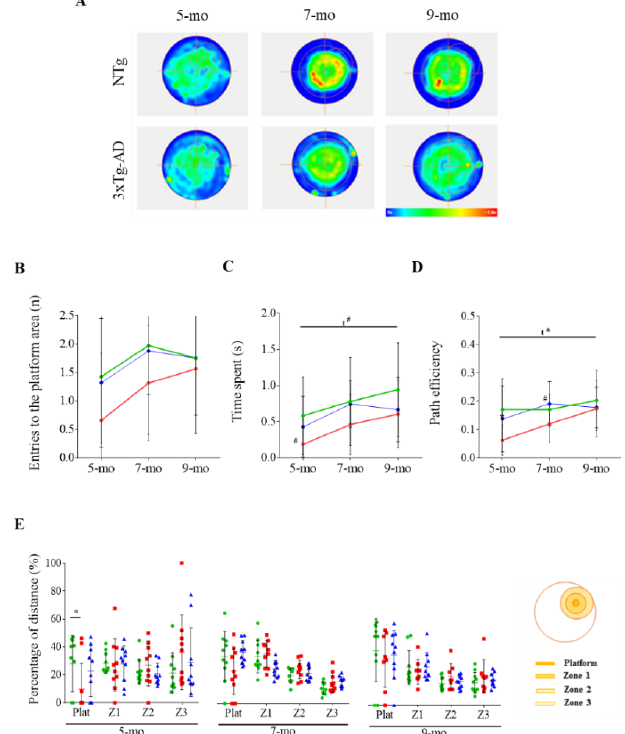
Figure 5. Long-term memory as assessed by the probe trial in the MWM. ( A ) Mean heat maps of the 5-, 7- and 9-month-old 3xTg-AD and NTg mice locations. Scale from blue (unoccupied regions) to red (the most occupied regions). ( B – D ) Evolution of NTg (in green), 3xTg-AD (in red), and